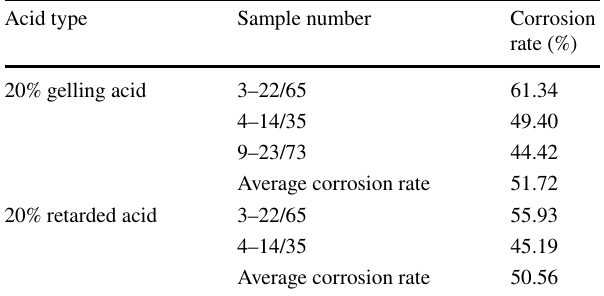
Table 3 Corrosion rates with different acids